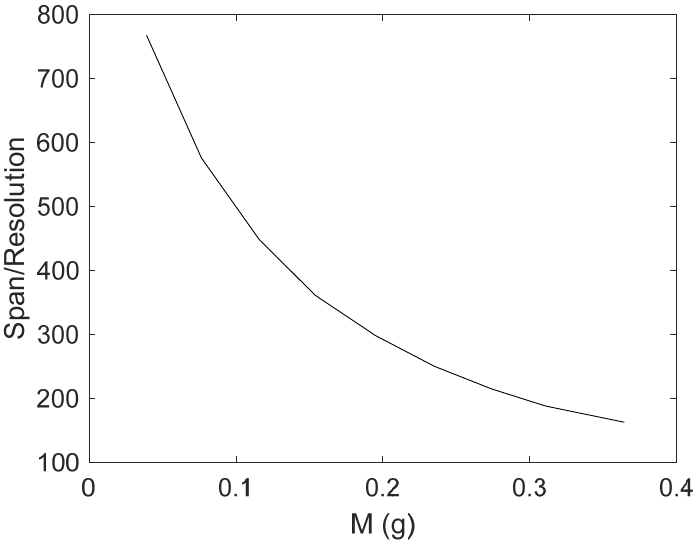
Figure 10. Span-to-Resolution of the mass sensor estimated in the following operating conditions: B = 0.0948 T and I d = 20 mA.